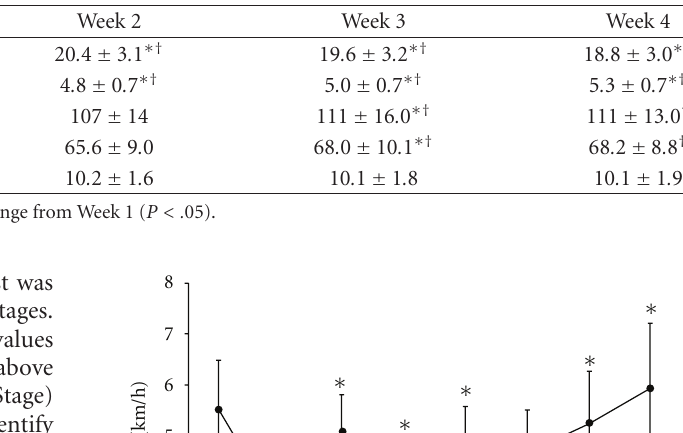
Table 1: Mean ( ± SD) performance, physiological, and perceptual responses from weeks 1 to 4.